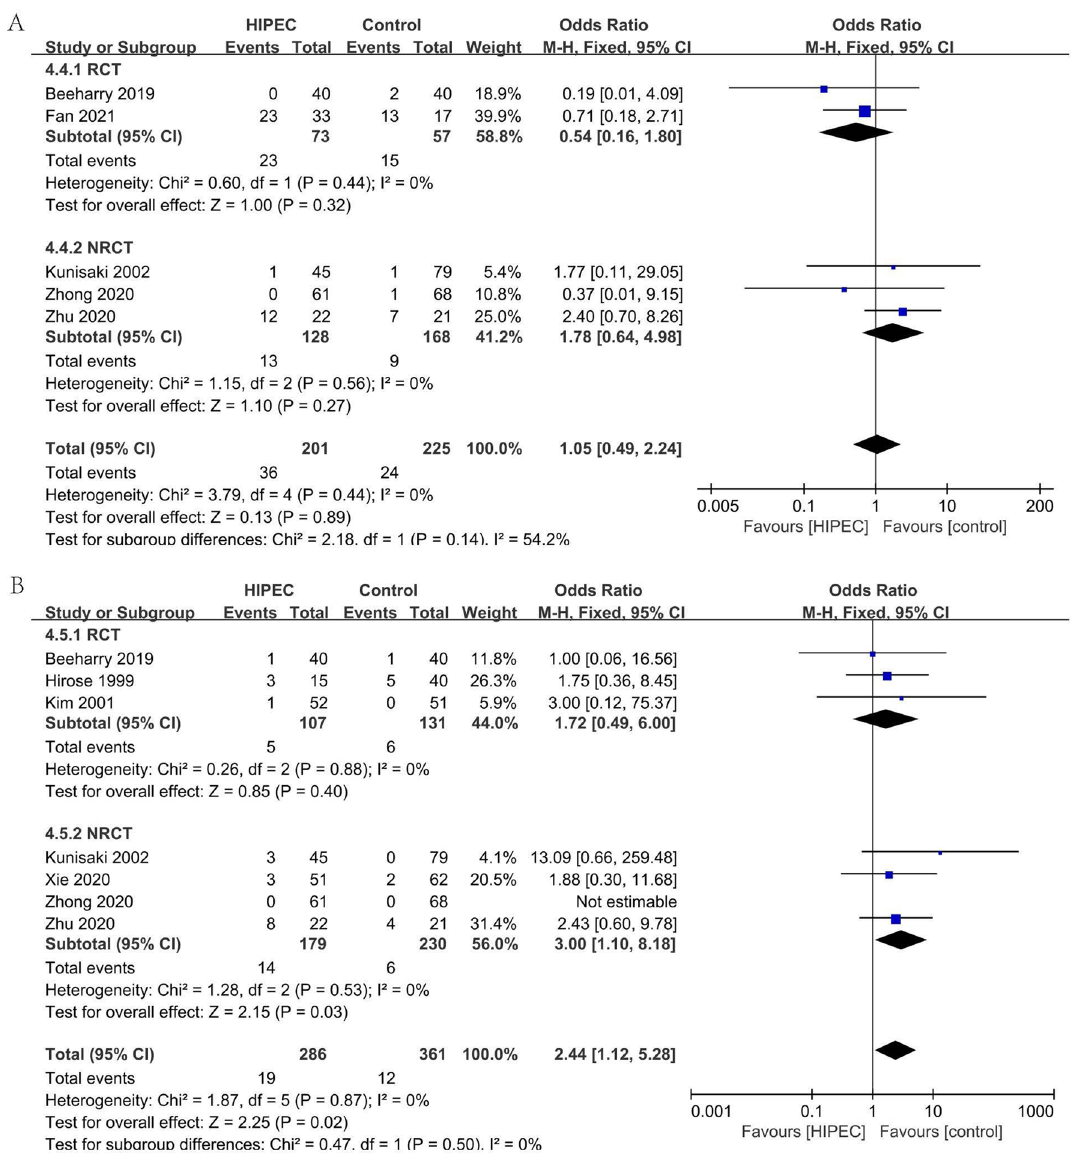
Figure 9. Complication: liver dysfunction ( A ), Complication: renal dysfunction ( B